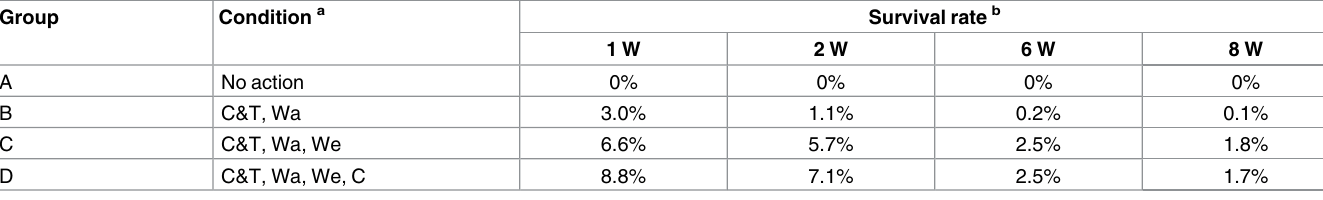
Table 3. Seedling survival rate during eight weeks in the field after sowing.